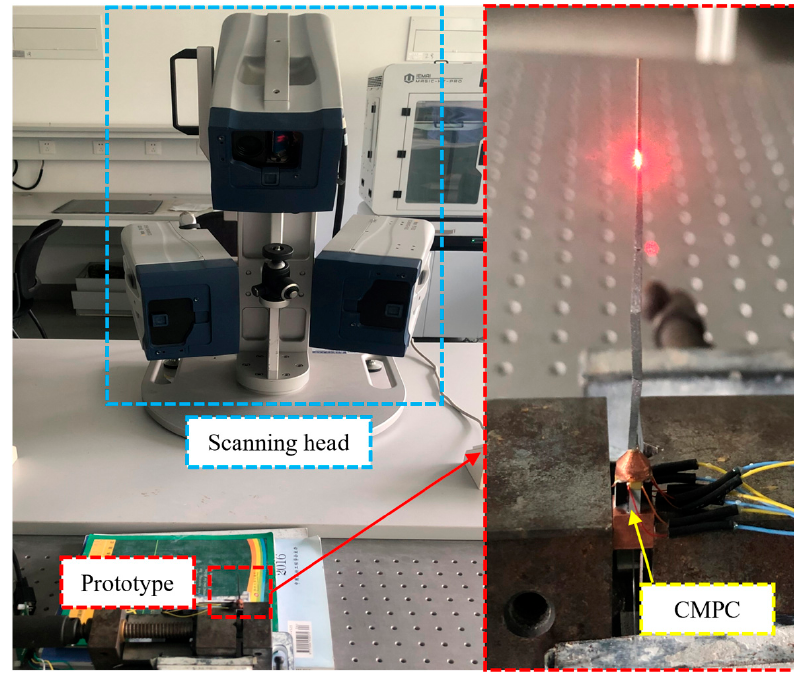
Figure 8. 3D vibration measuring